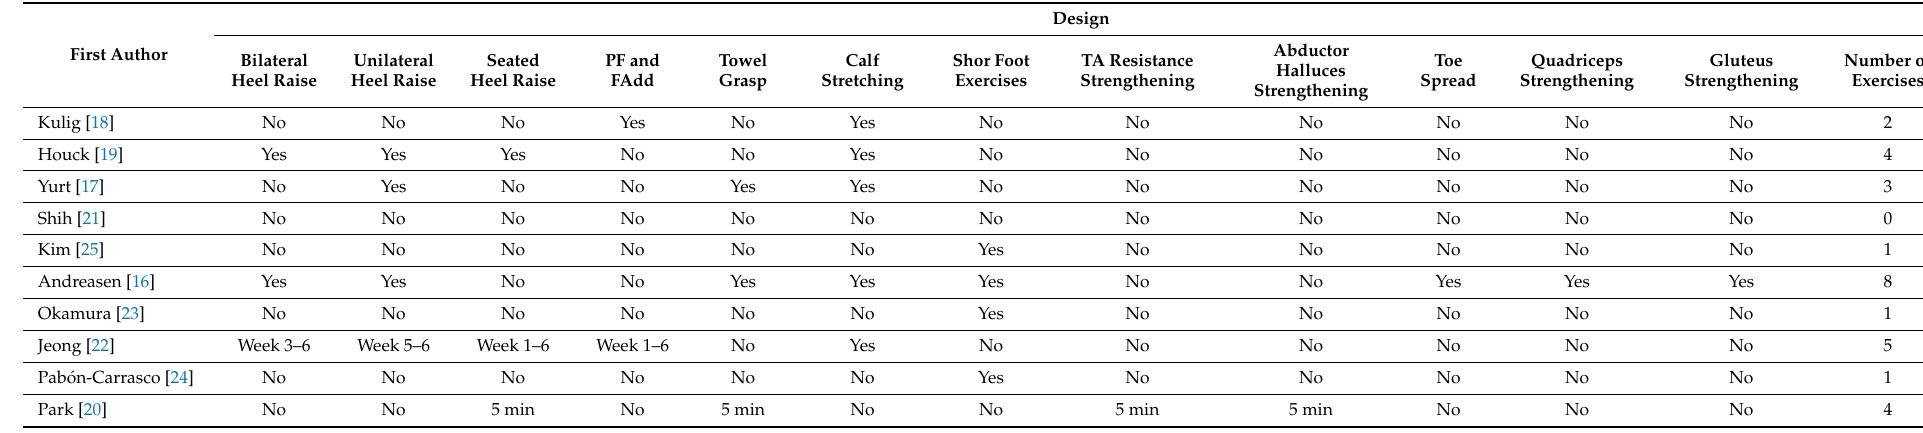
Table 3. Exercise design.